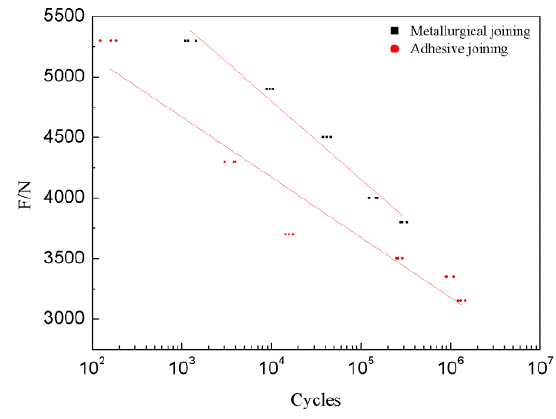
Figure 7. S-N curves of metallurgical joining and adhesive joining AFS. Table 2. Experimental data for three-point bending fatigue.